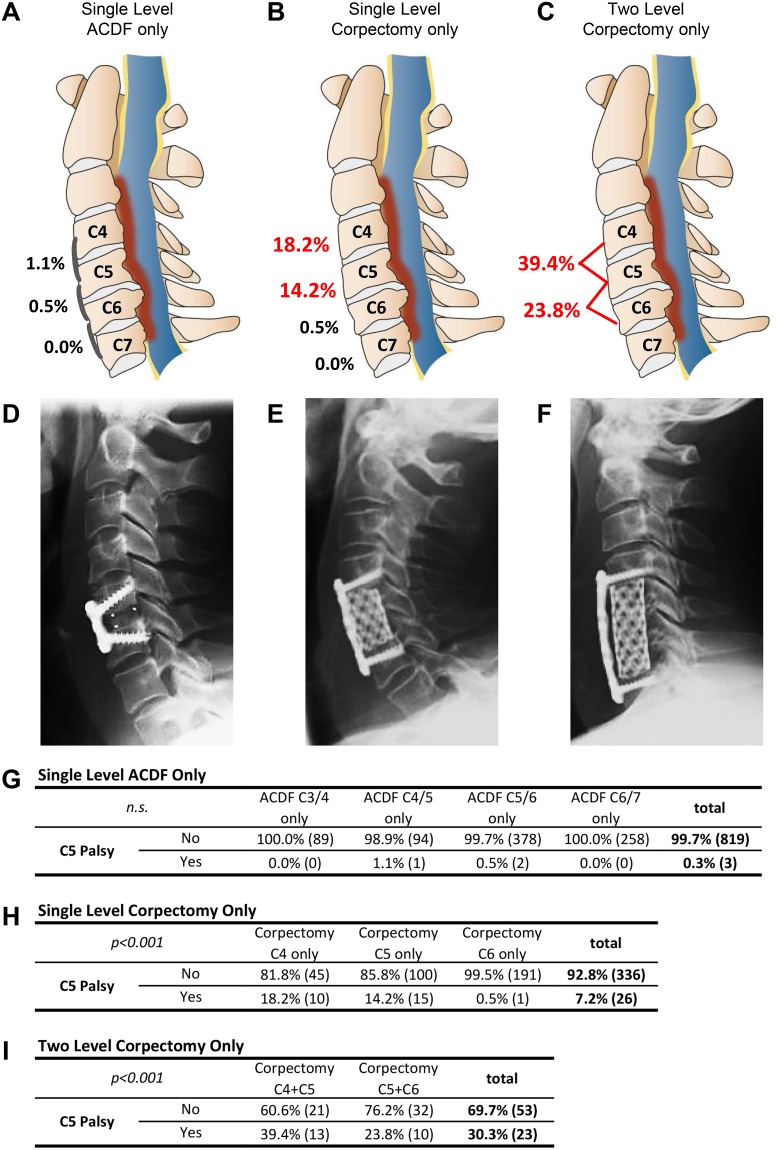
Schematic overview of C5 palsy rate for single level ACDF (A), single level corpectomy (B) or two level corpectomy (C) for the respective cervical level (not all levels shown). The cervical spine is shown in the sagittal view with the spinal cord marked in blue, the surrounding cerebrospinal fluid in yellow and a schematic stenotic narrowing in red. D-F shows representative corresponding lateral X-ray images of the surgical results. Single level ACDF (D), single level corpectomy (E) and two level corpectomy (F). Integrated tables G-I display the additional statistical values to the corresponding surgical strategies, including the overall C5 palsy rate for the respective surgical approach. Statistical analysis applied routine cross tables and chi2 testing.